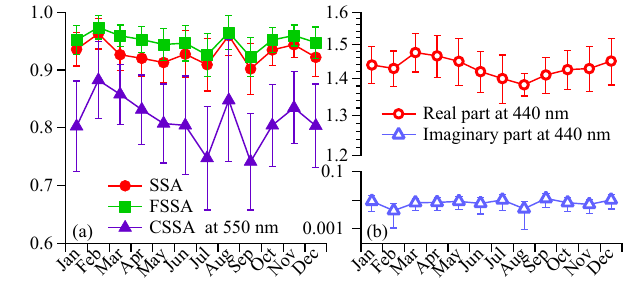
Figure 2. Monthly variations in the total (a) , scattering (b) and ab- sorbing aerosol (c) Ångström exponents (AE) at 440 / 870nm for the all, fine and coarse modes in the urban area of Nanjing.